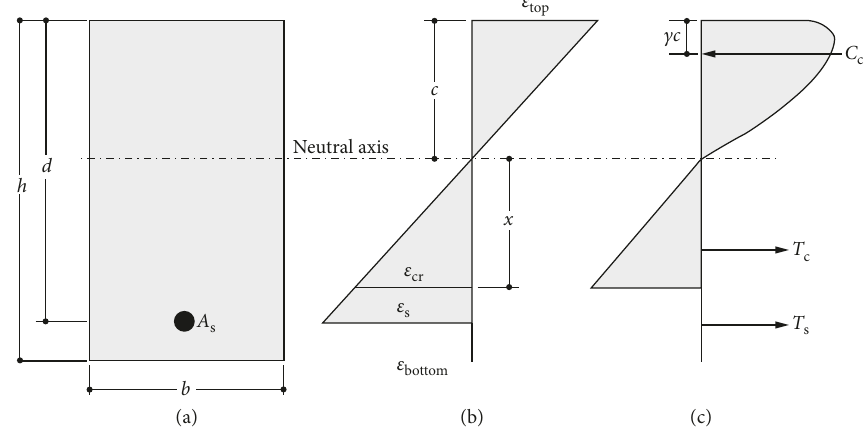
Figure 11: Strain compatibility of RC beam cross section for analysis [27]: (a) cross section; (b) strain distribution; (c) stress